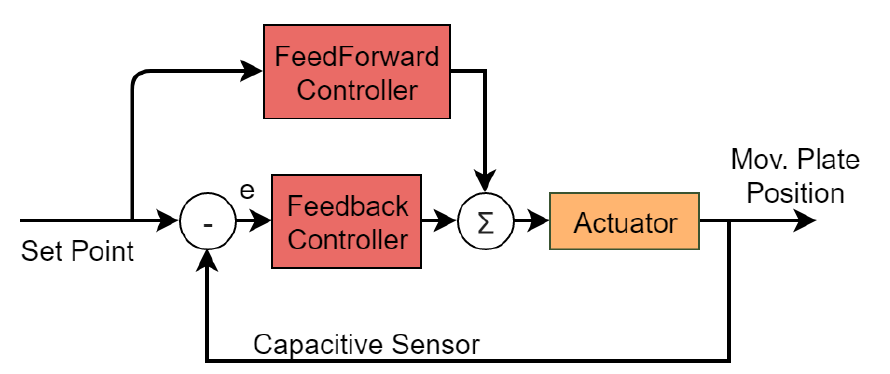
Figure 14. Movable plate control strategy (ILC).